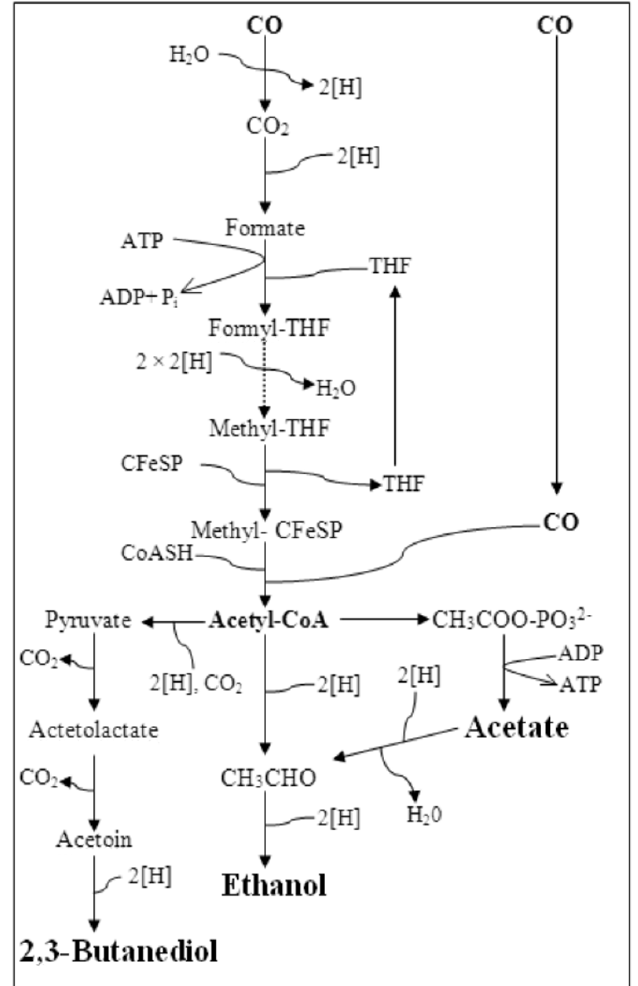
Figure 1. Wood-Ljungdahl pathway and metabolites formation from acetyl-CoA. Abbreviations: THF, tetrahydrofolate; CFeSP, corrinoid iron-sulphur